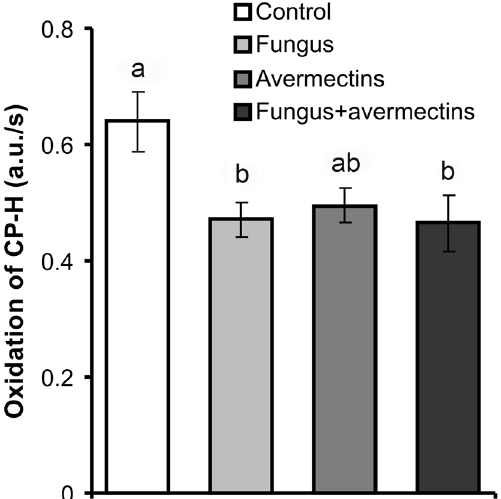
Figure 6. ROS production in the midgut tissue of Colorado potato beetle larvae at 48 h after topical treatment with M. robertsii conidia, oral administration of avermectins and the combined treatment. Different letters indicate significant differences between treatments (Tukey’s test, P < 0.05).